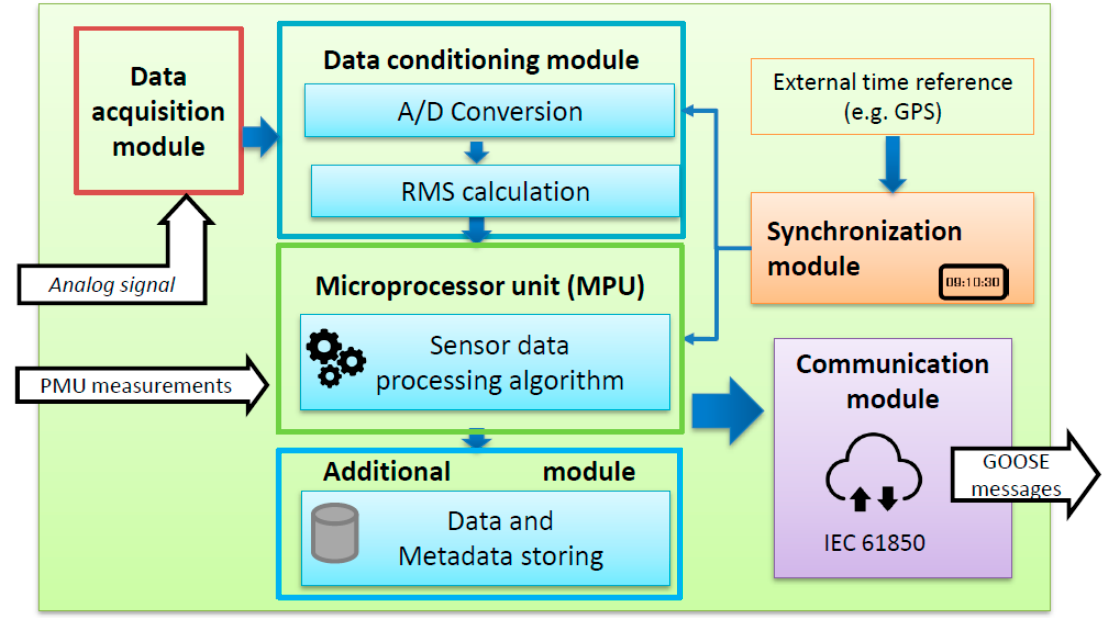
Figure 3. Structure of the relay-based smart sensor.